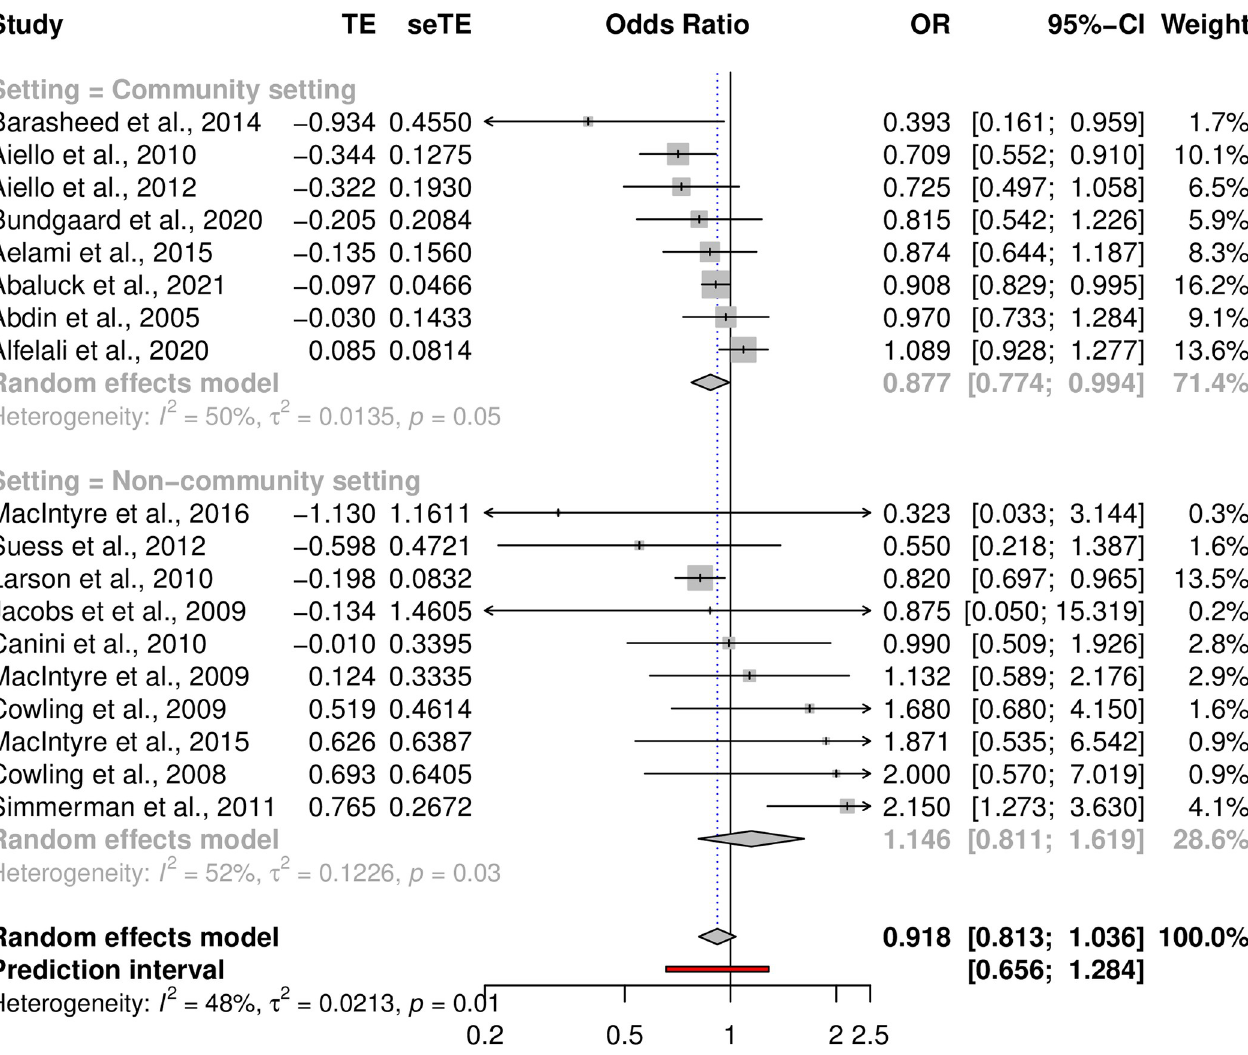
Fig 4. Effect of face masks across 18 studies using covariate adjusted odds ratios. Pooled effects across all 18 studies using a random-effects meta-analysis model. Seven of the 18 studies provided data for adjusted odds ratio estimates. For those studies that did not report adjusted odds ratio estimates we calculated unadjusted odds ratio estimates using the numbers of infected reported in the paper. TE = treatment effect and seTE = standard error of treatment effect, p- value = ξ 2 is the p-value for the test of homogeneity of study-specific effect sizes.